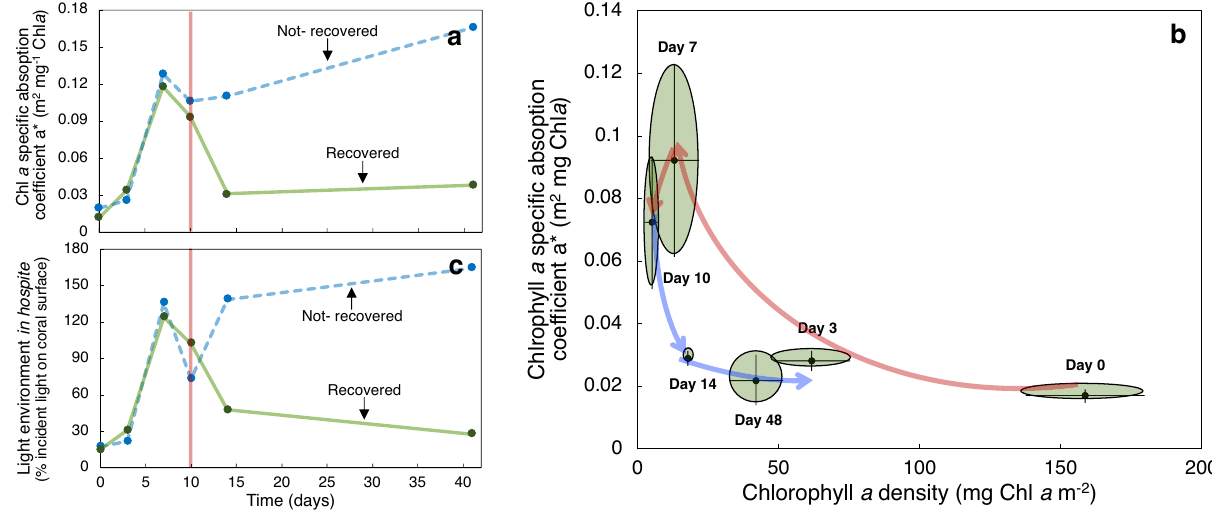
Figure 4. Variation of the chlorophyll a specific absorption coefficient (a* Chl a ; m 2 mg Chl a −1 ) and the predicted light environment in hospite of Orbicella faveolata fragments, during the B-Re experiment. Plots ( a , c ) describe the variation in: ( a ) the chlorophyll a specific absorption coefficient (a* Chl a ); and ( c ) the predicted light environment in hospite of the symbiotic algae through time in a recovered colony (green solid line) and in a colony that did not recover after the heat stress treatment (blue dashed line). Red vertical solid line represents the end of the heat stress period. Plot ( b ) describes the variation of a* Chl a as a function of changes in Chl a density in the intact coral. Day 1 to day 10 correspond to the heat stress period (32 °C, red arrows) whereas day 11 to day 40 represent the corals during the recovery period (28 °C, blue arrows).